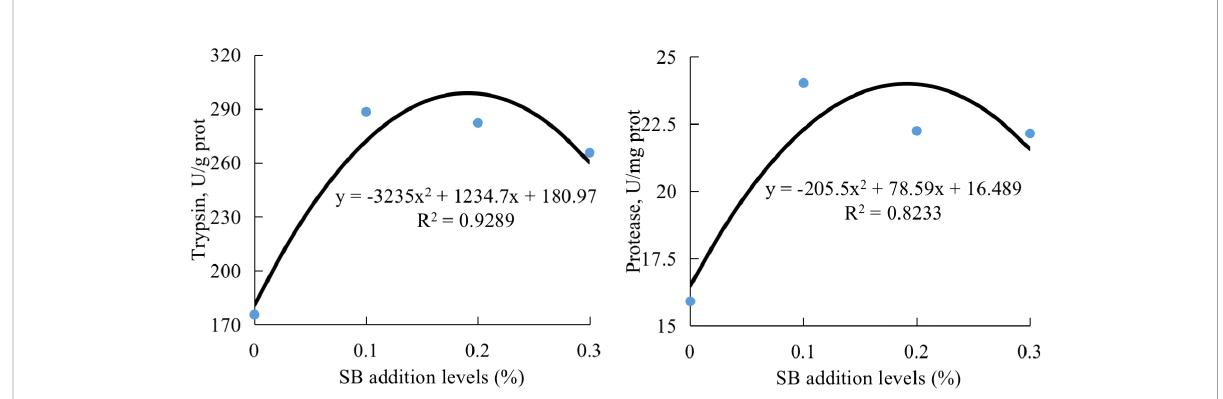
FIGURE 2 The relationship between intestinal activities of trypsin or protease of groupers and sodium butyrate (SB) inclusion levels in HSBM diets in a 56-d feeding period. Data are presented as the means of per dietary treatment. (n = 3 tanks). HSBM, 60% FM protein replacement with soybean meal (SBM) in FM diet and without SB addition; SB0.1, SB0.2 and SB0.3, 0.1%, 0.2%, and 0.3% SB were added in HSBM diets, respectively.